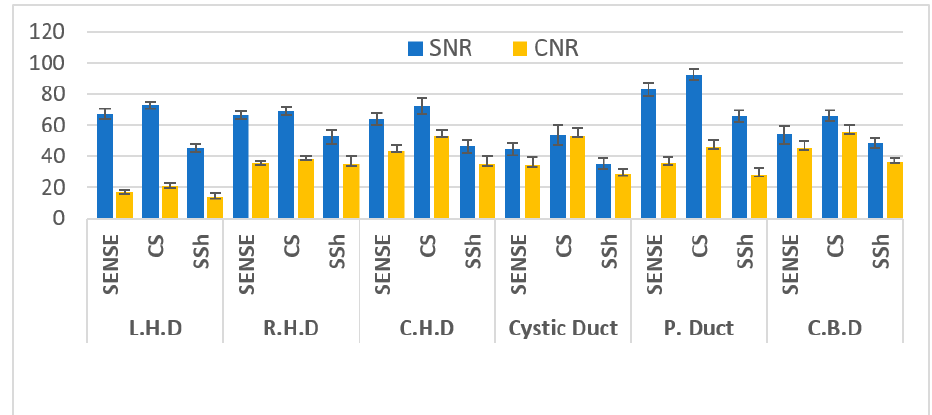
Figure 3. Statistical plots for SNRs and CNRs values in Volunteer’s MRCP Images. SENSE (Sensitivity-Encoded), CS (compressed SENSE), SSh TSE (Single-Shot Turbo Spin Echo). The SNR and CNR of common hepatic duct dilatation (CHDD), intraductal papillary mucinous neoplasm (IPMN), and liver cancer (LC) with biliary system lesions showed that LC (30%) was the highest at ≤ 1 mm, CHDD (35%) was the highest 2 mm or less, and IPMN (35%) was the highest between 1 and 2 mm. The measurements were in the order of BH-2D-SSh TSH < RT-2D-SENSE TSE < RT-2D-CS TSE, similar to the results of healthy people (Table 3, Figure 4) ( p < 0.05). Table 3. SNRs and CNRs values in Patient’s MRCP Images ( n = 20).